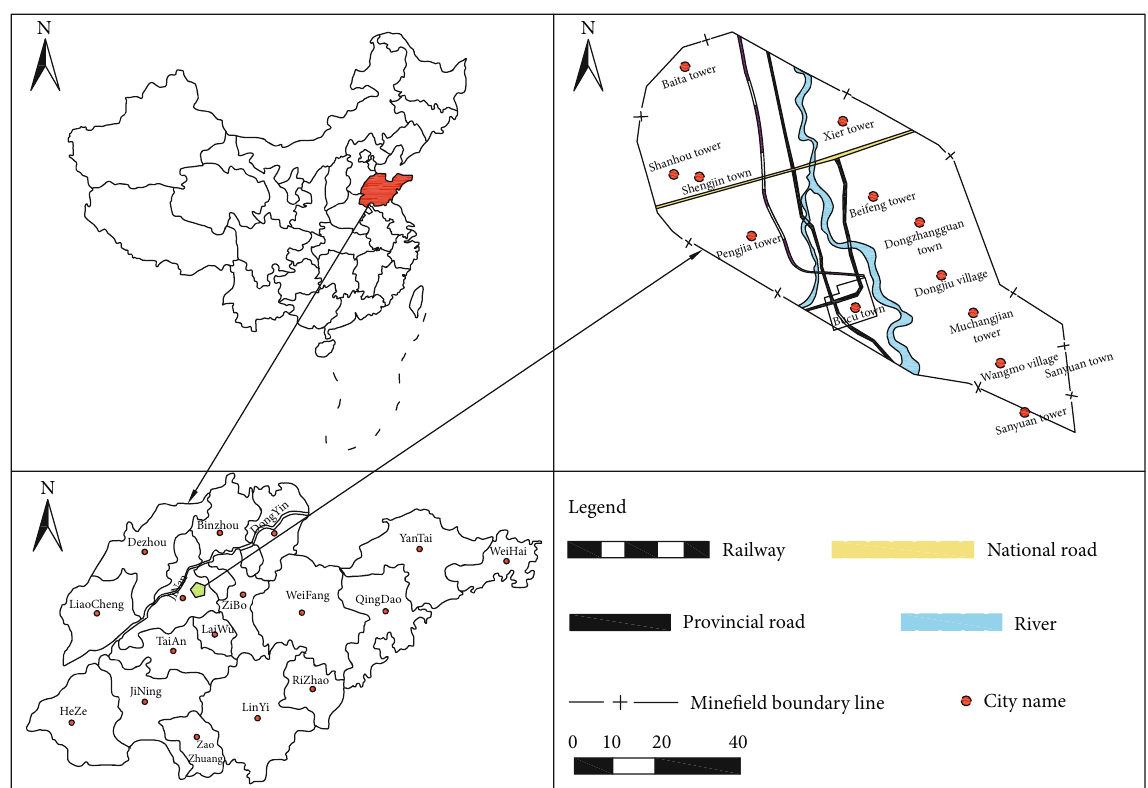
Figure 1: Location of the study area in Zhangqiu District,